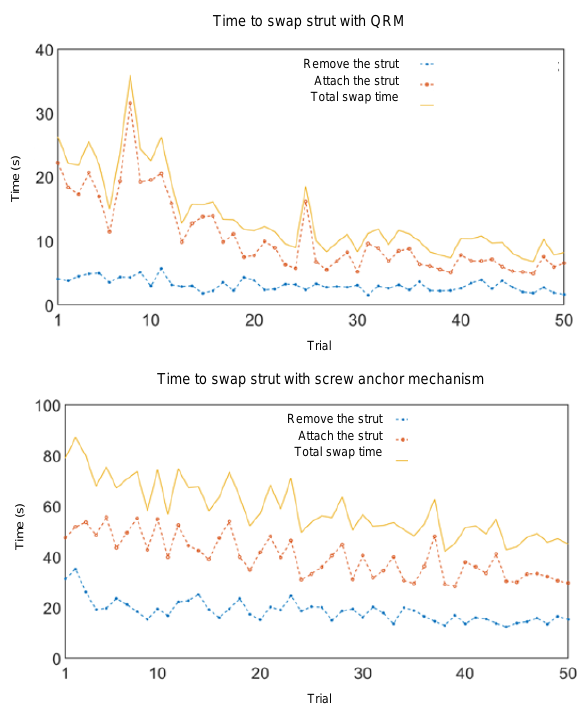
Figure 7: Time to swap strut with QRM and screw-anchor mechanism; including, strut removal time, strut attaching time, and total strut swap